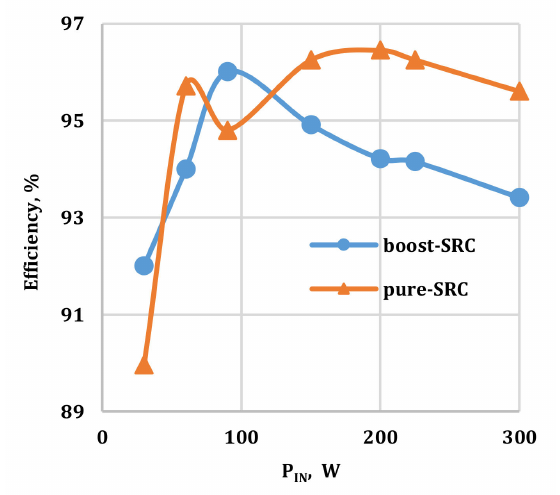
Figure 13. Measured efficiency of the proposed converter at the nominal input voltage of 30 V and in the boost-SRC at 25